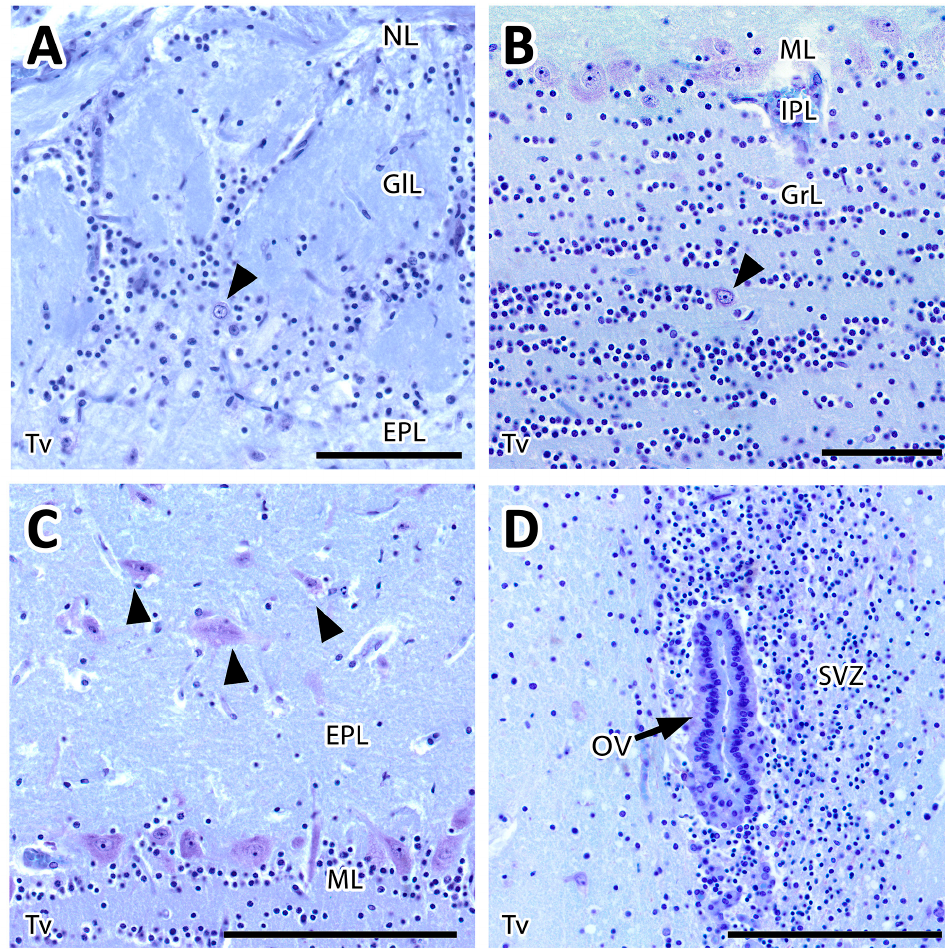
Figure 6. Histological study with Nissl stain of the structure of the main olfactory bulb. ( A ) The glomerular layer (GlL) comprises the typical spherical glomeruli surrounded by numerous periglomerular cells. Scattered neurons with large somas are also found (arrowhead). ( B ) The granular layer (GrL) is formed by neat clusters of granule cells interspersed with large neuronal somas (arrowhead). ( C ) Mitral cells somas are aligned along the mitral layer (ML), whereas the external plexiform layer (EPL) contains tufted cells (arrowheads). ( D ) The deep area of the MOB contains the rostral horn of the lateral ventricle, the olfactory ventricle (OV), with its ependyma (arrow) and a dense proliferative zone characteristic of the subventricular zone (SVZ) neuroprogenitor cells. NL, nerve layer. Scale bars: ( A , B ) 50 µ m; ( C , D ) 100 µ